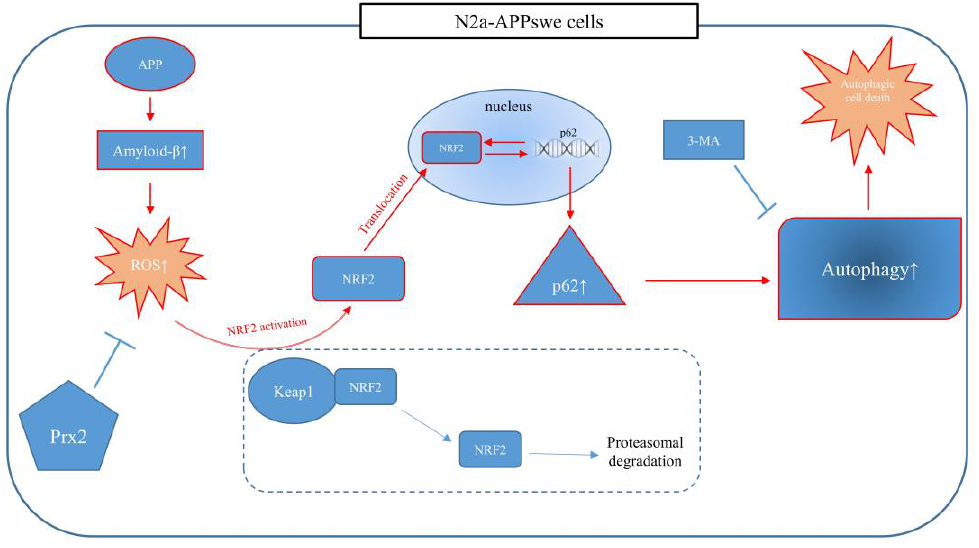
Figure 7. A schematic diagram demonstrates that Prx2 decreases AβO -mediated autophagy by in-